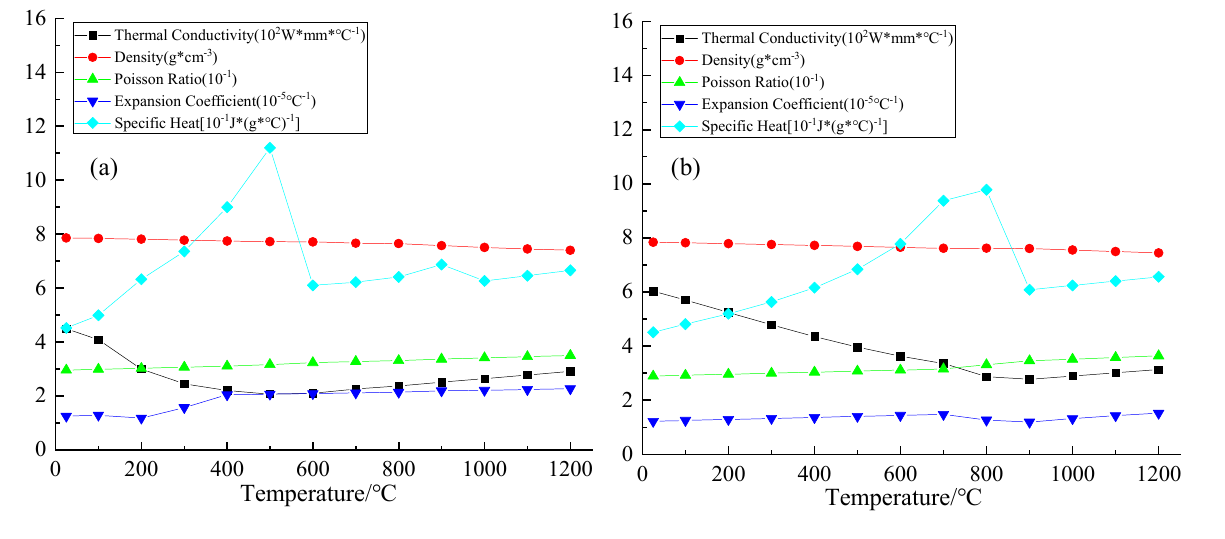
Figure 9. High temperature performance parameters of materials. ( a ) 316L; ( b ) Q235B.